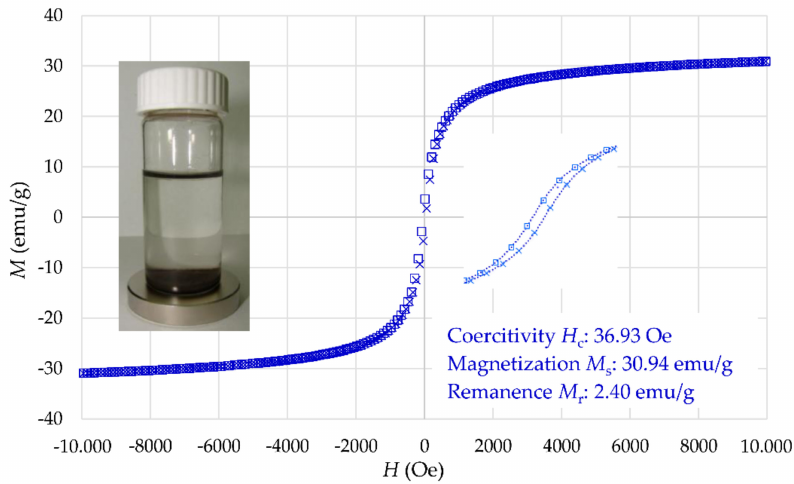
Figure 8. Magnetization curve of γ -Fe 2 O 3 -NH 4 OH@SiO 2 (APTMS)